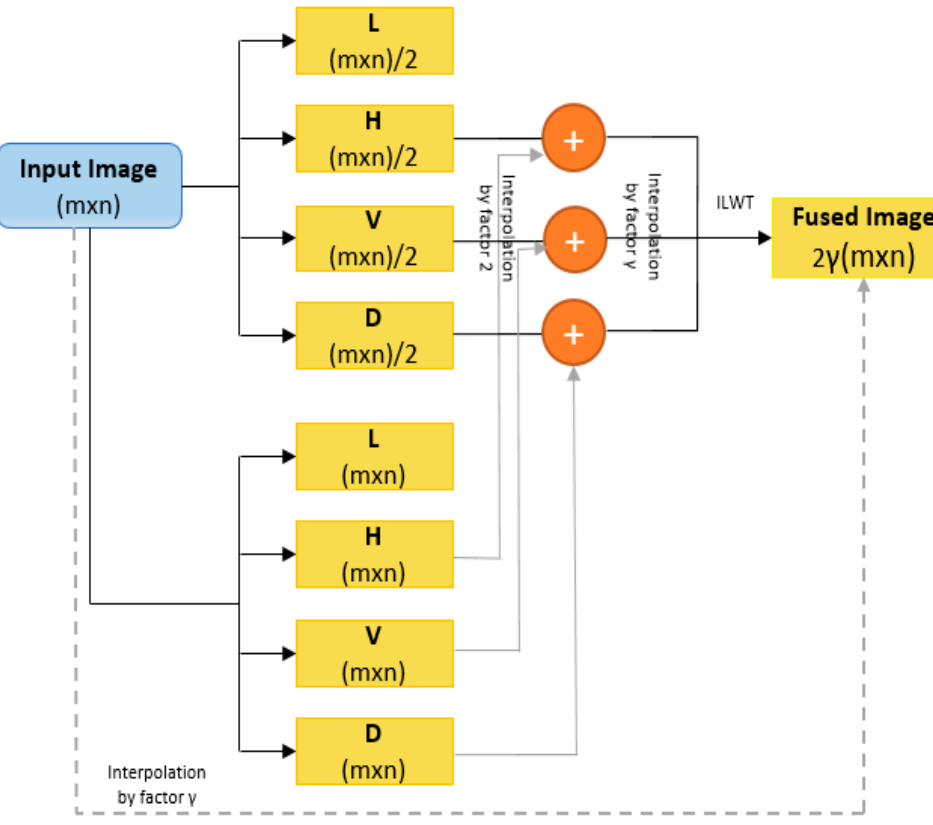
Figure 4. Intensity